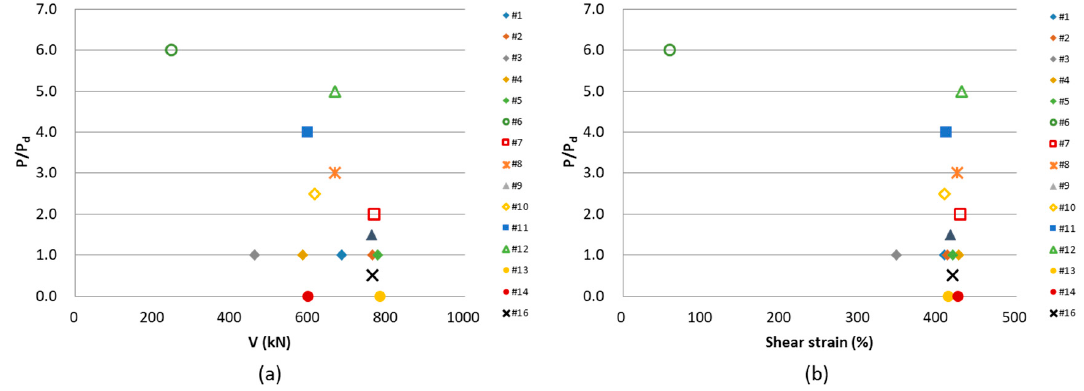
Figure 16. Ultimate property diagram in ( a ) shear force and ( b ) shear strain.